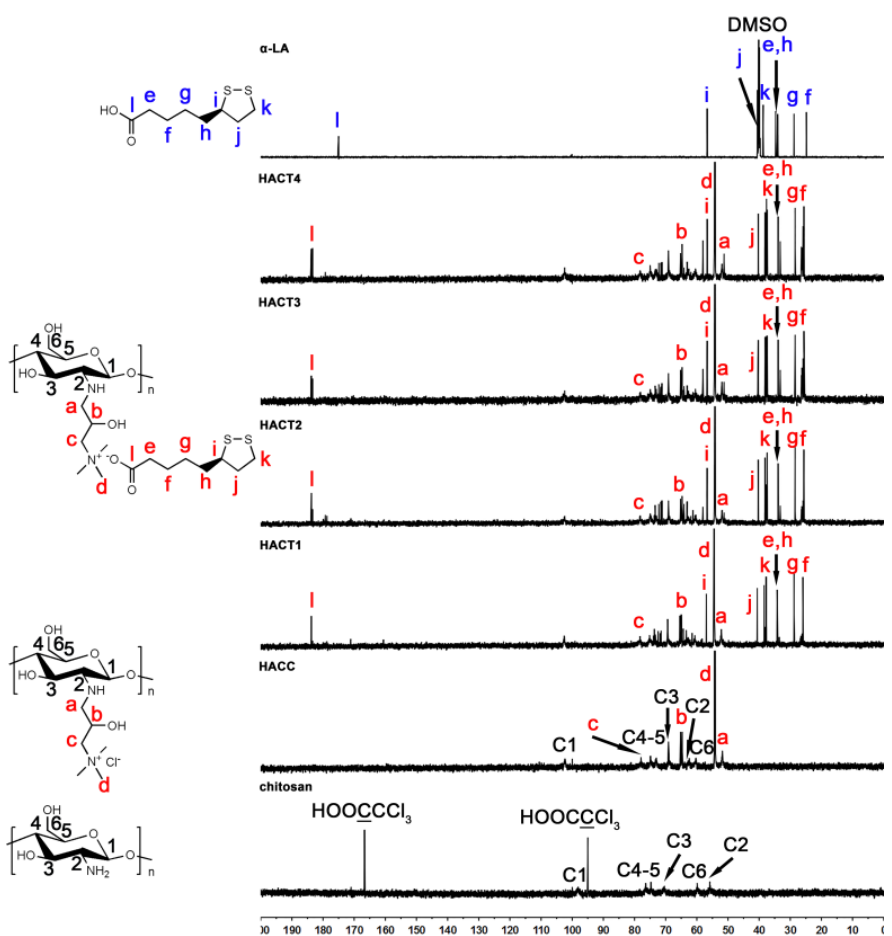
Figure 3. 13 C NMR spectra of chitosan and chitosan derivatives.